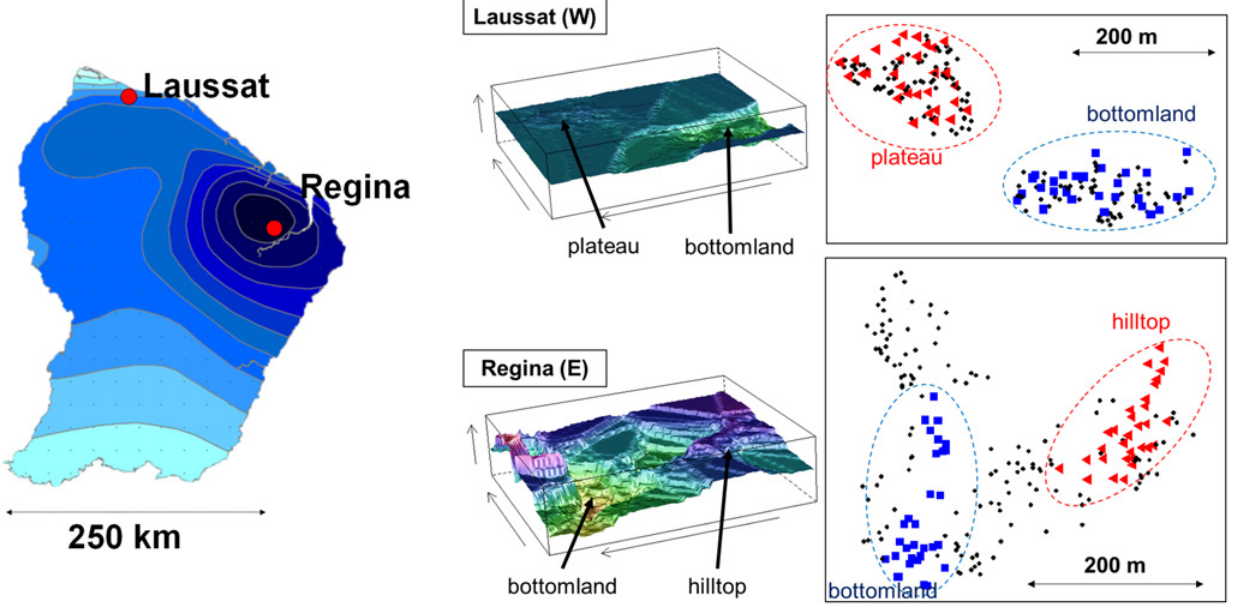
Fig 1. Geographic and topographic situation of the study sites. Colored dots: trees sampled for genotyping (triangles: hilltop; squares: bottomland).